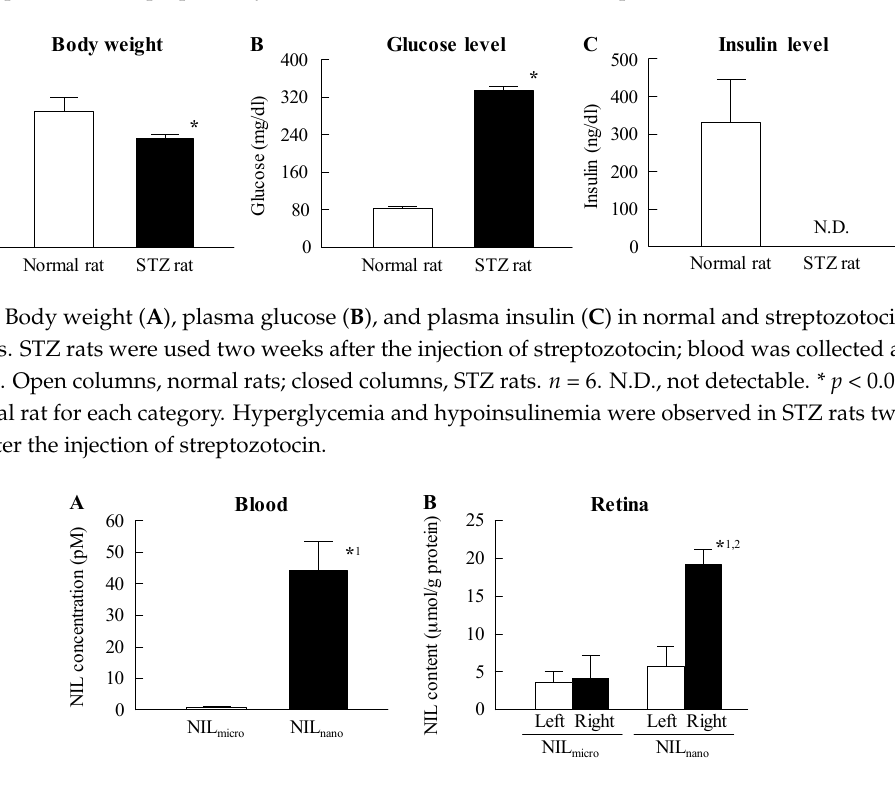
Figure 1. Size frequency distribution and images of 1% NIL microparticles (NIL micro ) and nanoparticles (NIL nano ). ( A ) and ( B ): cumulative size distribution and frequency of NIL micro ( A ) and NIL nano ( B ). Dashed line, cumulative size distribution; solid line, cumulative size frequency; ( C ) SPM image of NIL nano . The image was obtained with an SPM-9700. The NIL nano (ophthalmic formulation containing NIL nanoparticles) was prepared by bead mill treatment, and the mean particle size was 77 nm.